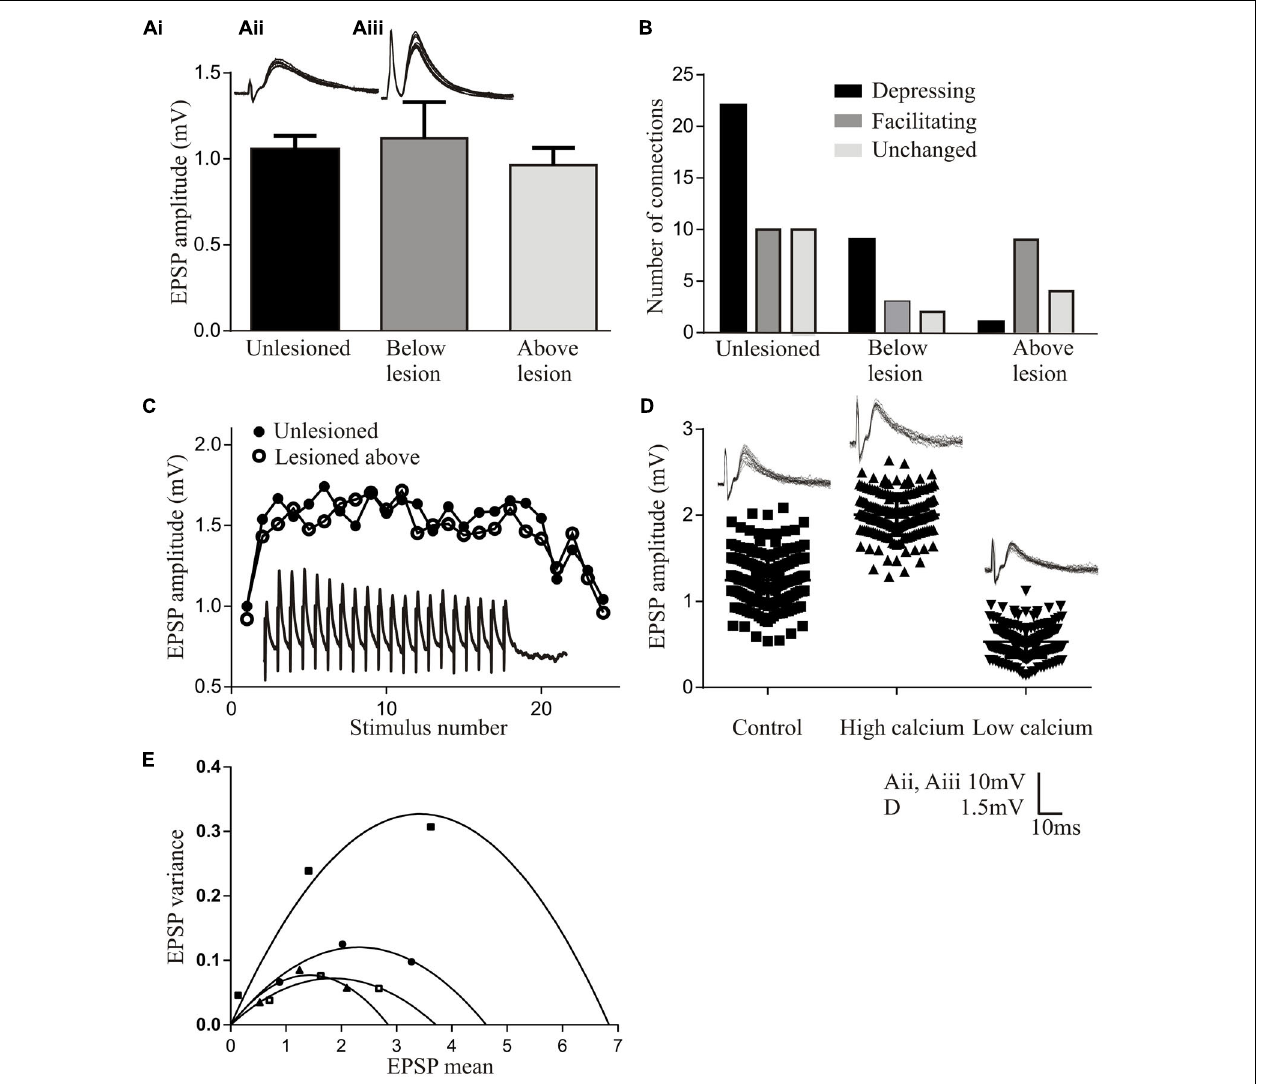
FIGURE 2 | Properties of regenerated synapses. (Ai) The initial EPSP amplitude from reticulospinal axons in unlesioned and lesioned spinal cords. The inset shows the largest response seen in an unlesioned spinal cord (Aii) , and the occasional very large inputs seen in lesioned animals (Aiii) . (B) Proportions of connections showing different forms of activity-dependent plasticity in unlesioned and lesioned spinal cords. (C) Graph comparing facilitation in unlesioned spinal cords and from above the lesion site. The inset shows facilitation above the lesion. (D) The effect of high and low Ca 2 + on the properties of reticulospinal EPSPS. (E) Variance-mean plots in high and low calcium for four